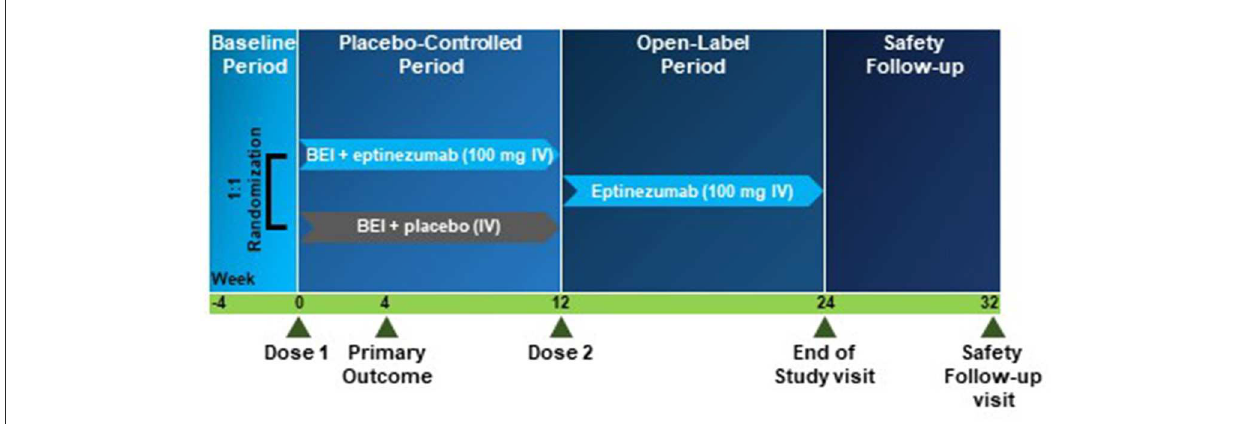
FIGURE1 RESOLUTION study design. Study design for the randomized clinical trial included a baseline period (screening; 4 weeks), a placebo-controlled period (12 weeks) supplemented with Brief Educational Intervention (BEI), an open-label period (12 weeks), and a safety follow-up period (8 weeks). BEI, Brief Educational Intervention; IV, intravenous.